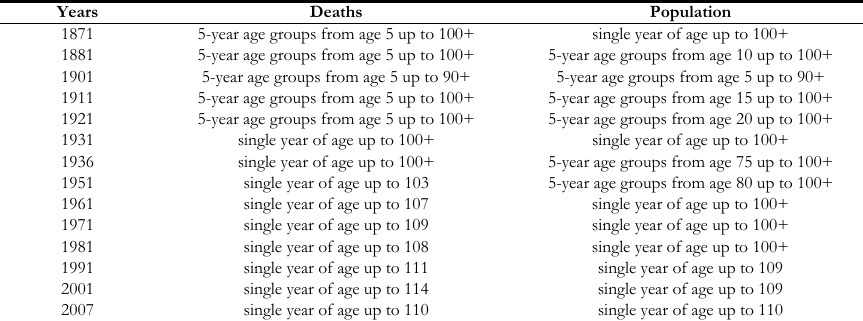
Number of deaths and present population by available age classification